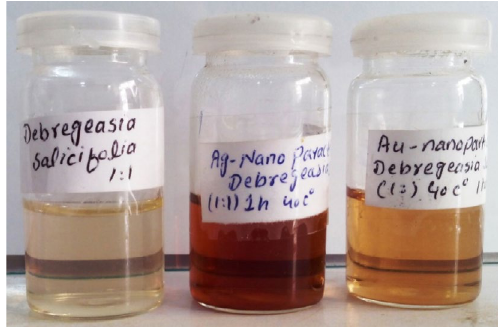
Fig. 6. Colour changes of Ag/AuNPs from D.